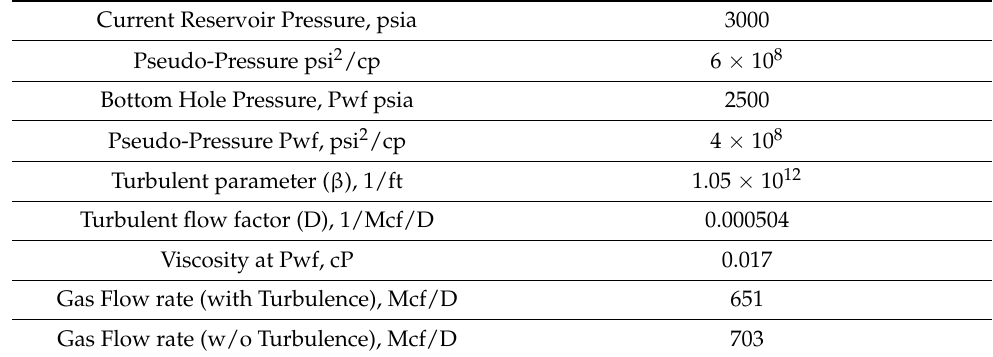
Table 3. Flow and pressure parameters.